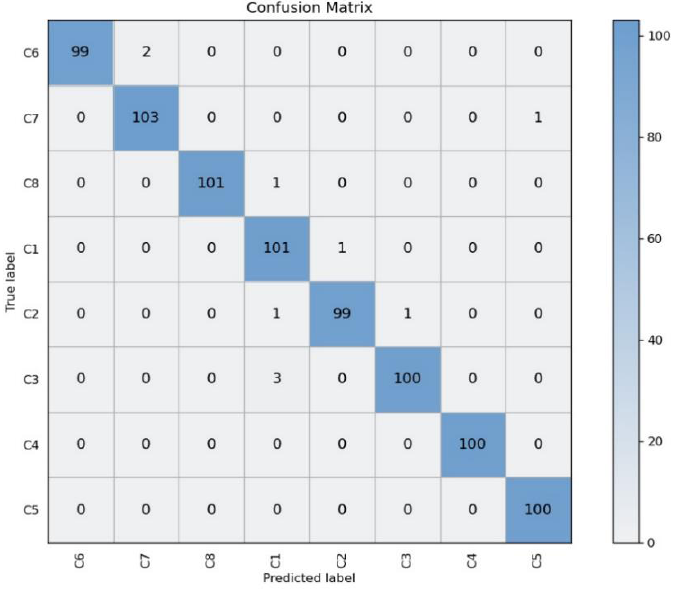
Figure 15. Confusion matrices of MobileNetV3 for the test image dataset. Table 3. The prediction result of the